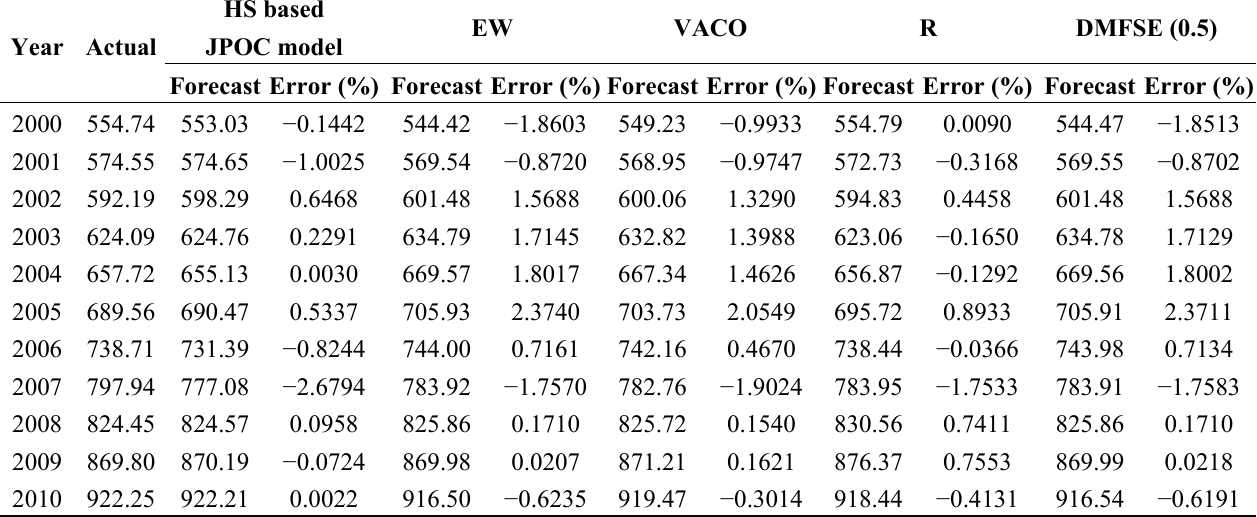
Table 11. Forecasting results of the HS-based JPOC model and the other combination models for India (TWh).